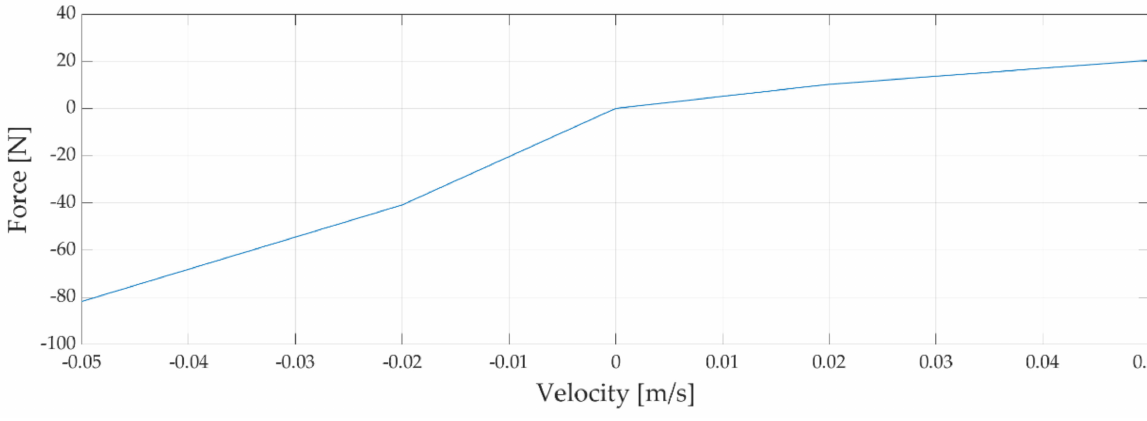
Figure A1. Baseline model front damper Force/Velocity